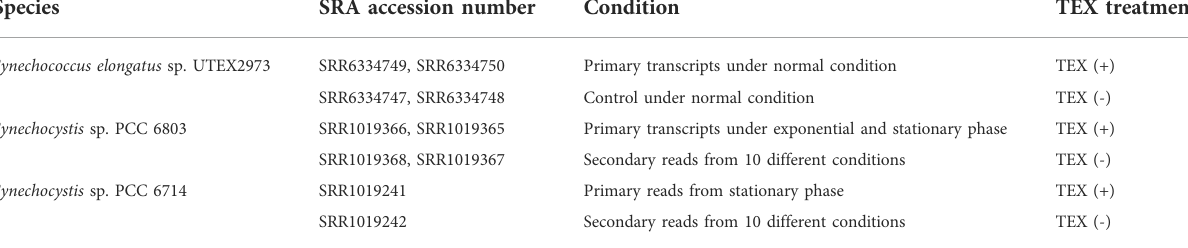
TABLE 1 Datasets employed in this